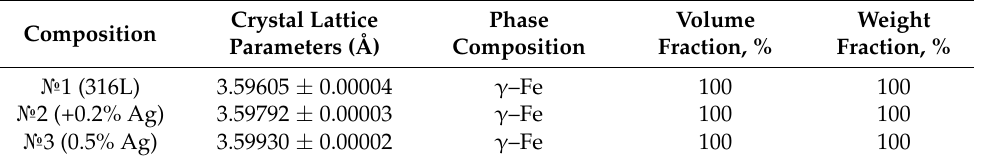
Table 2. Phase composition and crystal lattice parameter of ingots.